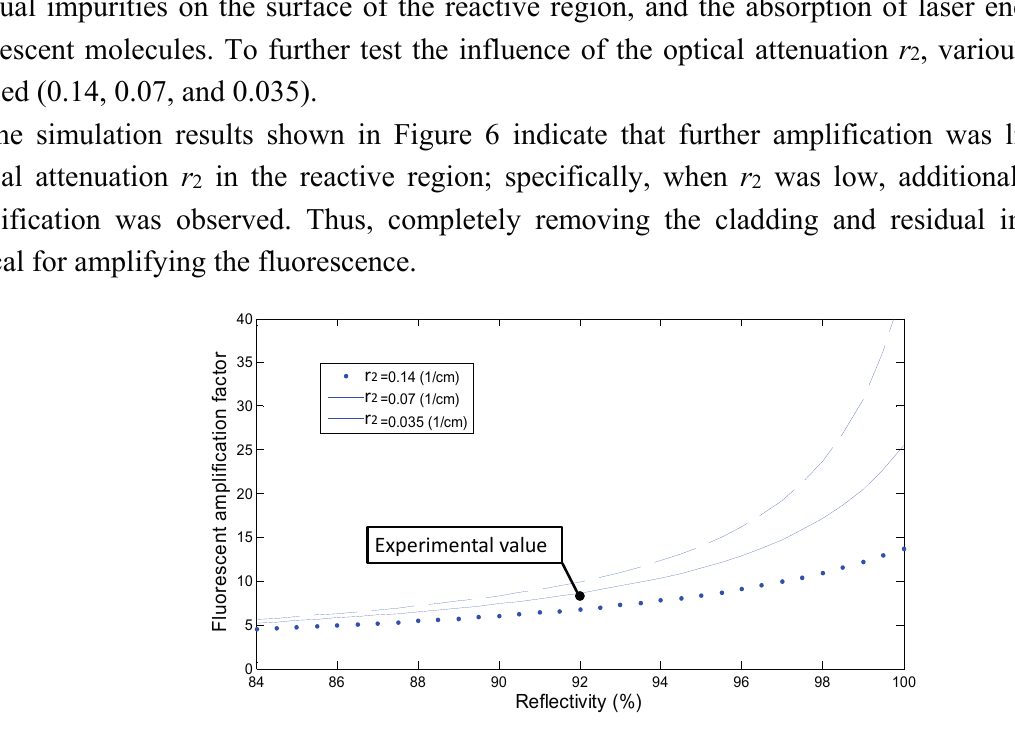
Figure 6. Simulation of the amplification factor versus reflectivity and optical attenuations r 2 in the reactive area.